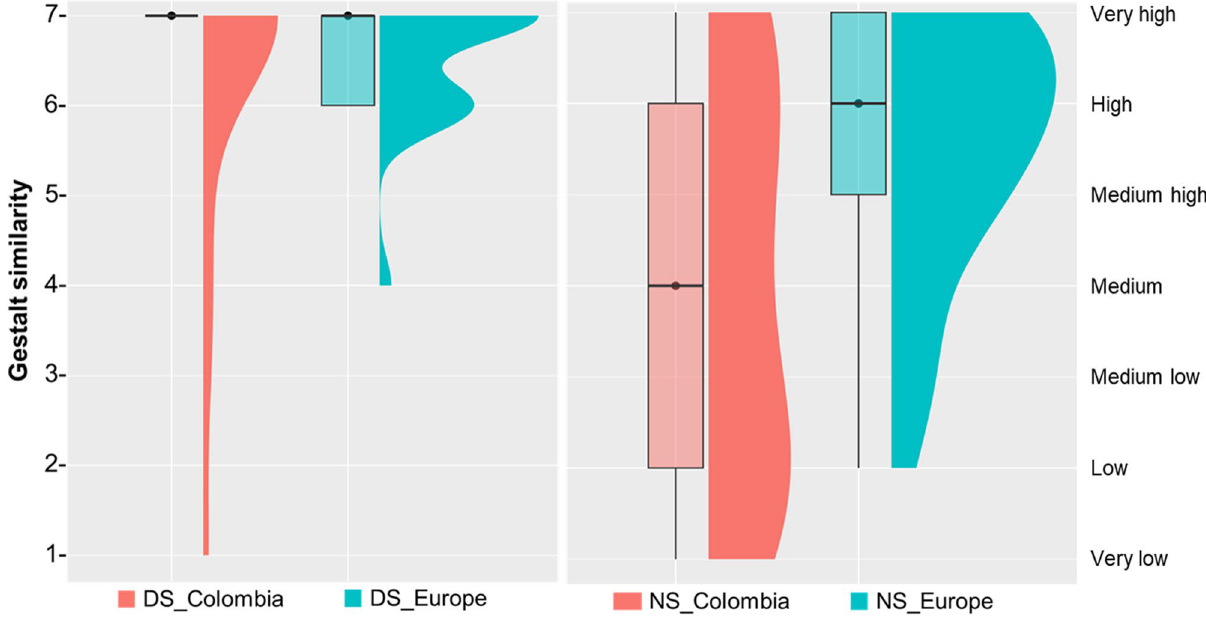
Figure 7. Comparison of gestalt similarity scores between Colombian and European populations in Down and Noonan syndromes. Raincloud plots are based on top-5 accuracy Face2Gene predictions within family disorder, and show the corresponding average gestalt similarity score, the range of variation, and the distribution within each disorder and